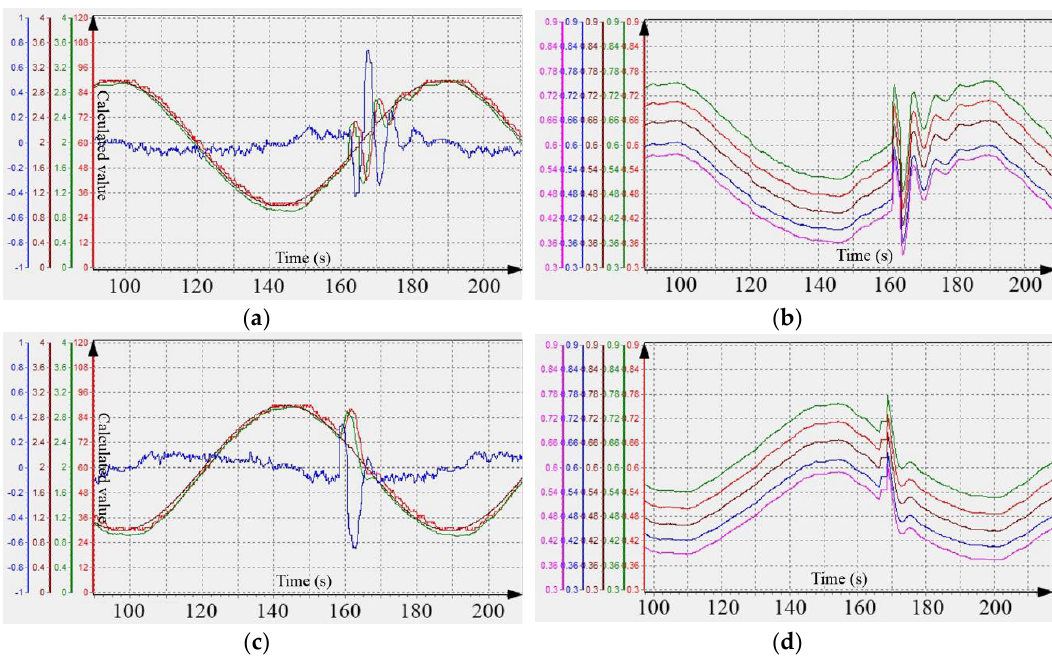
Figure 16. Dynamic characteristics analysis of disturbance condition. ( a ) Adaptive curve under equipment output disturbance; ( b ) Weight update curve under equipment output disturbance; ( c ) Adaptive curve under feedback signal disturbance; ( d ) Weight update curve under feedback signal disturbance.